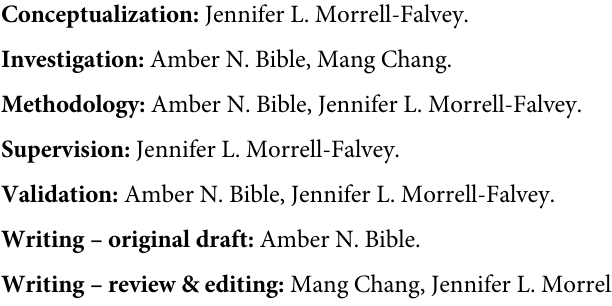
(TIF) S2 Fig. Expression of individual diguanylate cyclases using RT-PCR. Image shown is repre- sentative of a minimum of 3 replicates. (TIF) S3 Fig. Western blot showing expression of tagged full length DGC2884 and DGC2884 Δ TM. Weights of markers are indicated on the left and arrows point to bands that represent the indicated protein. (TIF) S4 Fig. Growth curves of wild type Pantoea sp. YR343 and indicated transposon mutants in minimal media (A) and in LB media (B). Error bars represent the standard deviation from three independent cultures. (TIF) S5 Fig. Clustal Omega multiple sequence alignment of Pantoea sp. YR343 DGC2884, Pseu- (TIF) S1 Table. Strains and plasmids used in this study. (PDF) S2 Table. Primers used in this study. (PDF) S1 Raw images. Original gel and Western blot images corresponding to S2 and S3 Figs.